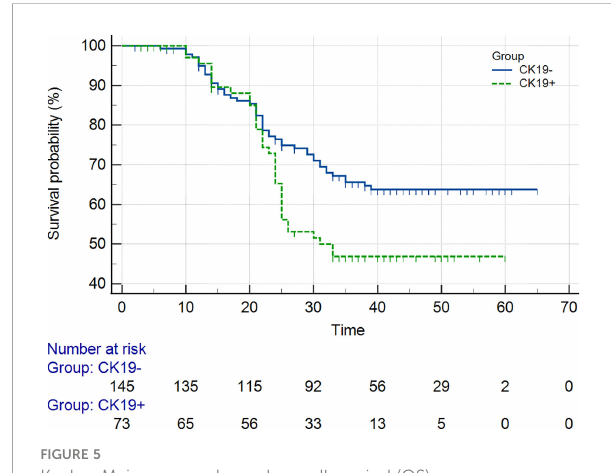
FIGURE 5 Kaplan-Meier curves showed overall survival